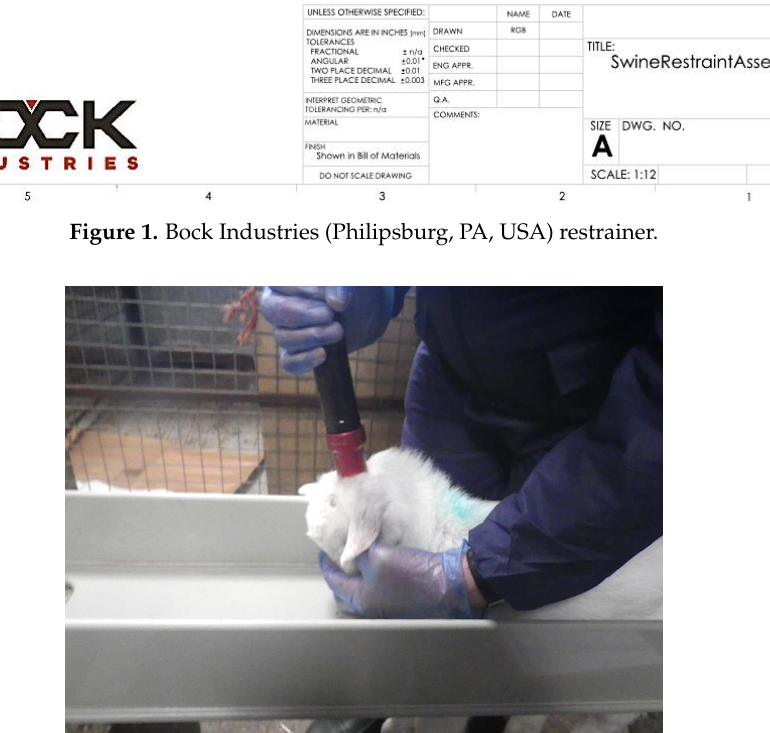
Figure 2. Restrainer in use (revised shot position technique, see below).